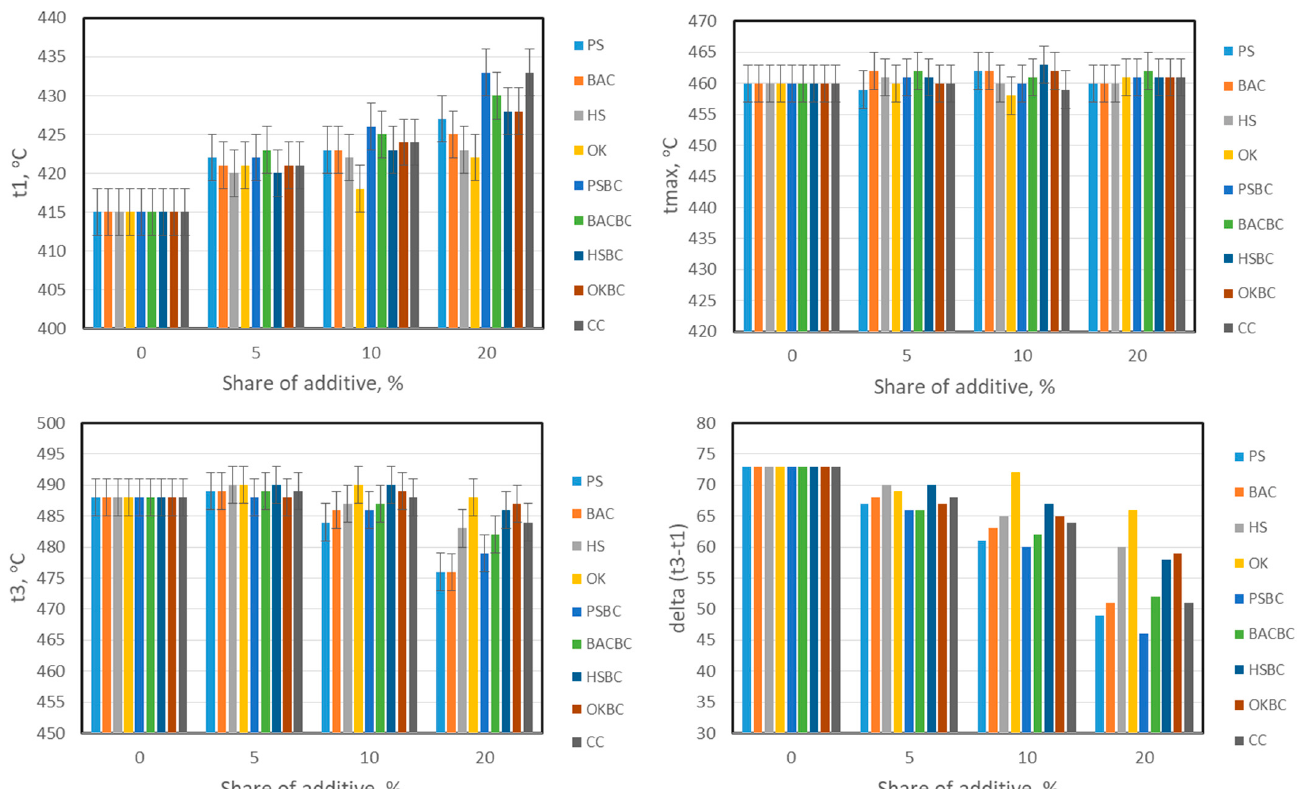
Figure 3. Influence of type and share of bio-components on characteristic temperatures of fluidity.